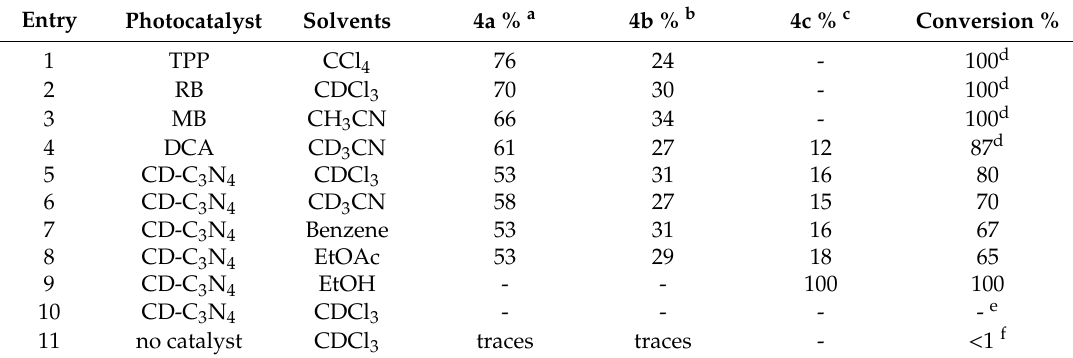
Table 2. Regioselectivities and activities of various sensitizers in the photooxygenation of 4 .